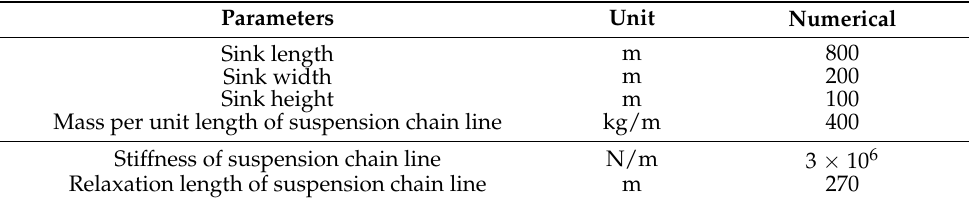
Table 3. Numerical water tank and suspension chain line parameters table.